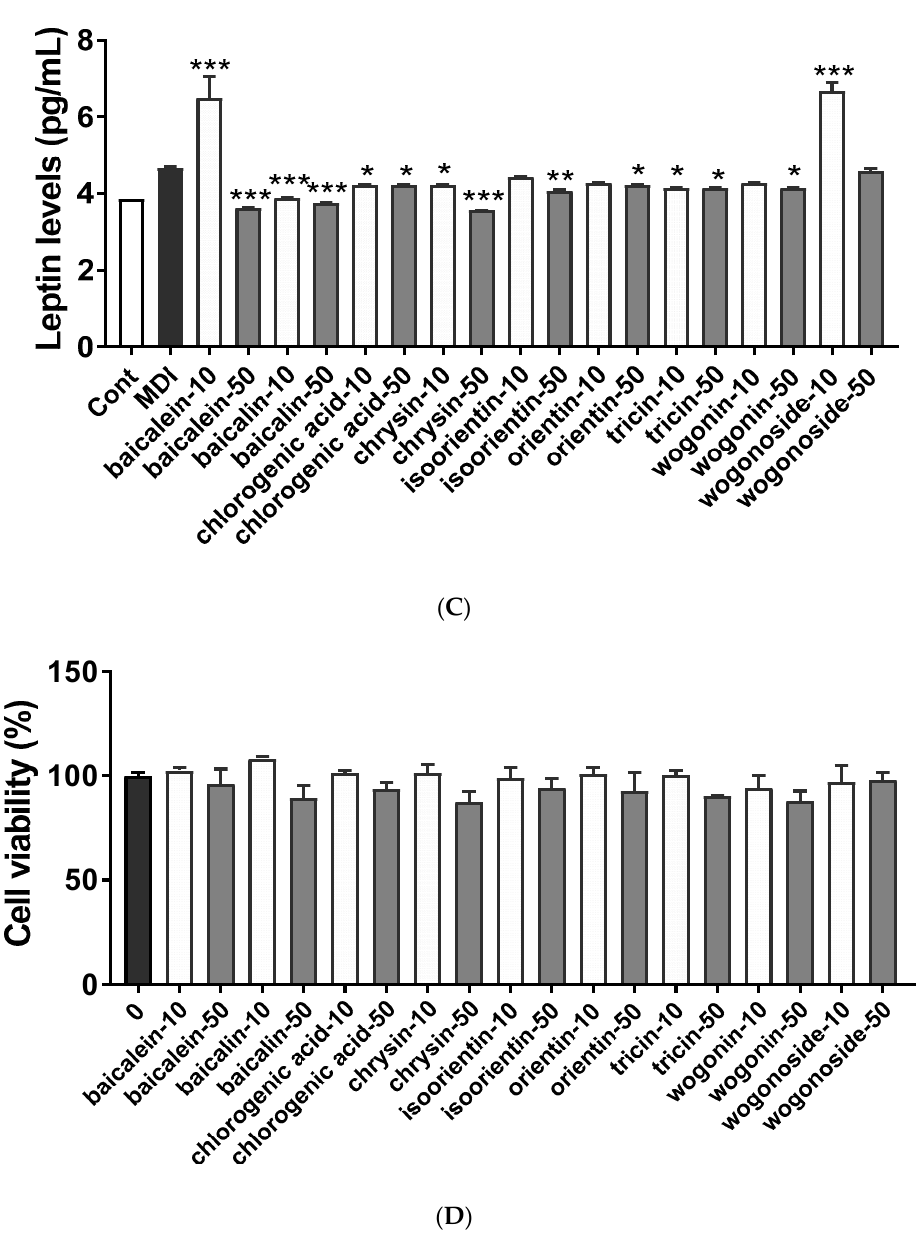
Figure 5. Effect of a 2:1 mixture of Phyllostachys pubescens and Scutellaria baicalensis (BS21) constituents on adipocyte differentiation in 3T3-L1 cells. ( A ) Oil Red O staining of intracellular triglycerides in 3T3-L1 cells. 3T3-L1 cells were treated with compounds (10 and 50 µg/mL) during differentiation induction. ( B ) Relative densities of lipid contents. ( C ) Leptin levels. ( D ) Cell viability. Values are expressed as means ± SD ( n = 3). Significant differences were observed between control (undifferentiated preadipocytes) and differentiated MDI cells: # p < 0.05, ## p < 0.01, and ### p < 0.001. Significant differences were observed between differentiated MDI (3-isobutyl-1-methylxanthine, dexamethasone, and insulin) cells and BS21-treated cells: * p < 0.05, ** p < 0.01, and *** p < 0.001.